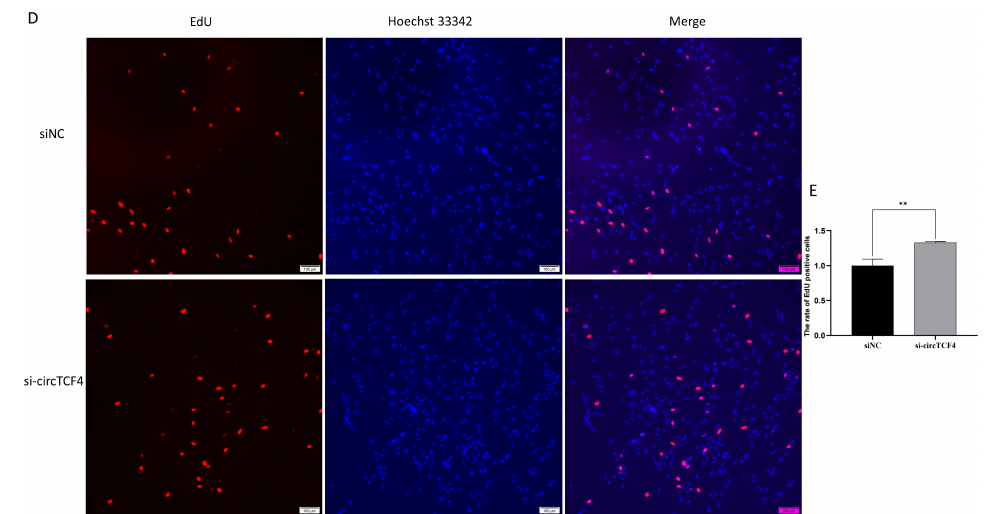
Figure 3. Effect of circTCF4 deficiency on the proliferation of MuSCs in goats. ( A ) Changes in circTCF4, Pax7 mRNA, PCNA mRNA, CCND1 mRNA, CDK2 mRNA, and P57 mRNA expression altered by interfering with circTCF4. ( B ) Changes in TCF4 mRNA expression. ( C ) The absorbance of cells at 450 nm. ( D ) The number of EdU stained nuclei in cells. ( E ) Statistical results of EdU positive cells. Data are means ± standard error from at least three biological replicates, ** p < 0.01 and *** p <